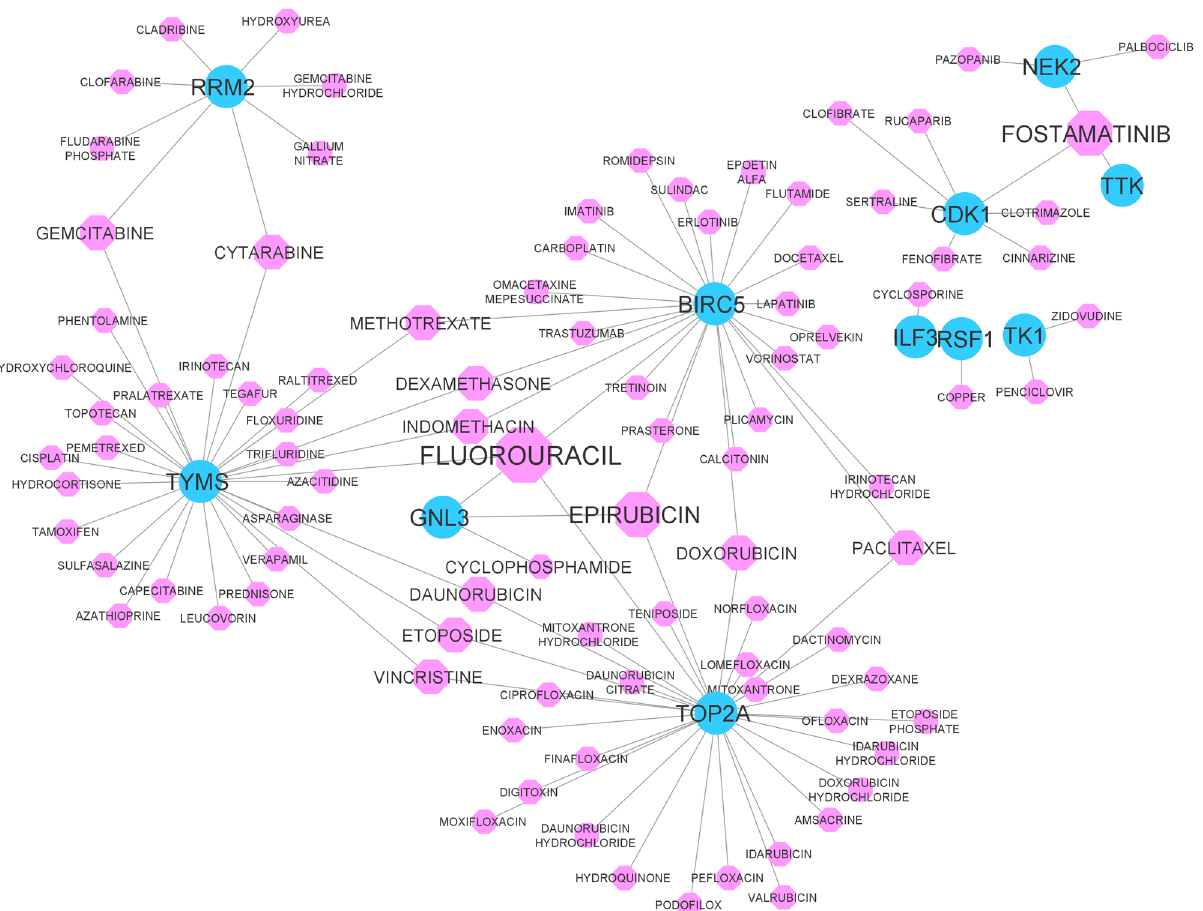
Figure 3. The drug-gene interaction network for TF-miRNA-TG_A and TF-miRNA-TG_B sub-networks. Blue circles show TGs, and pink octagons show drugs. The size of the octagon nodes indicates its degree. The high degree drug is FLUOROURACIL with 4 target